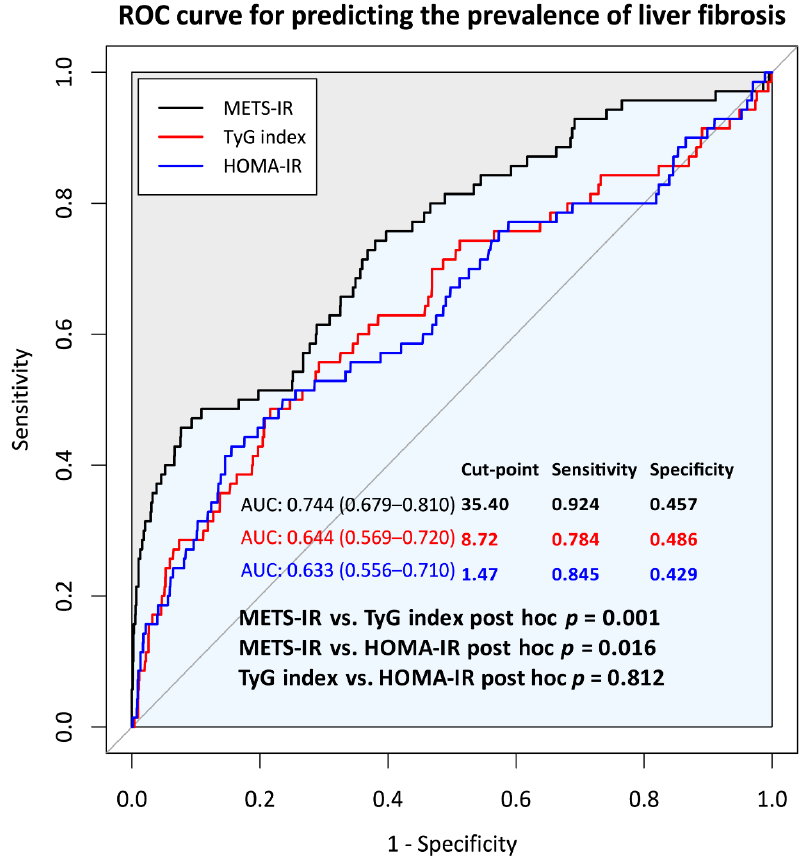
Figure 1. Comparison of the abilities to predict ALF of three different insulin resistance indices. The gray line shows the chance level performance. Abbreviation: ALF, advanced liver fibrosis.